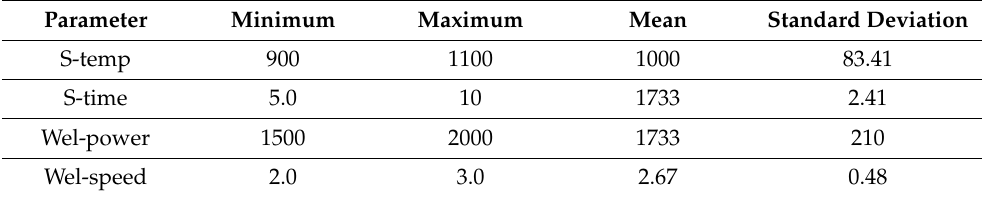
Table 3. Parameters and their range used in the artificial neural